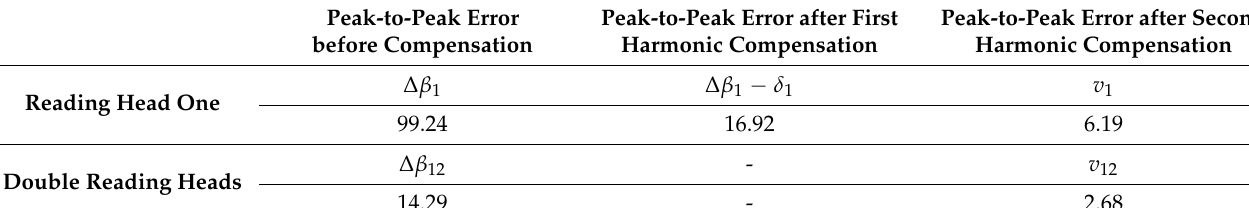
Table 7. Comparison of the peak-to-peak error between reading head one and the double reading heads (unit: arc second).